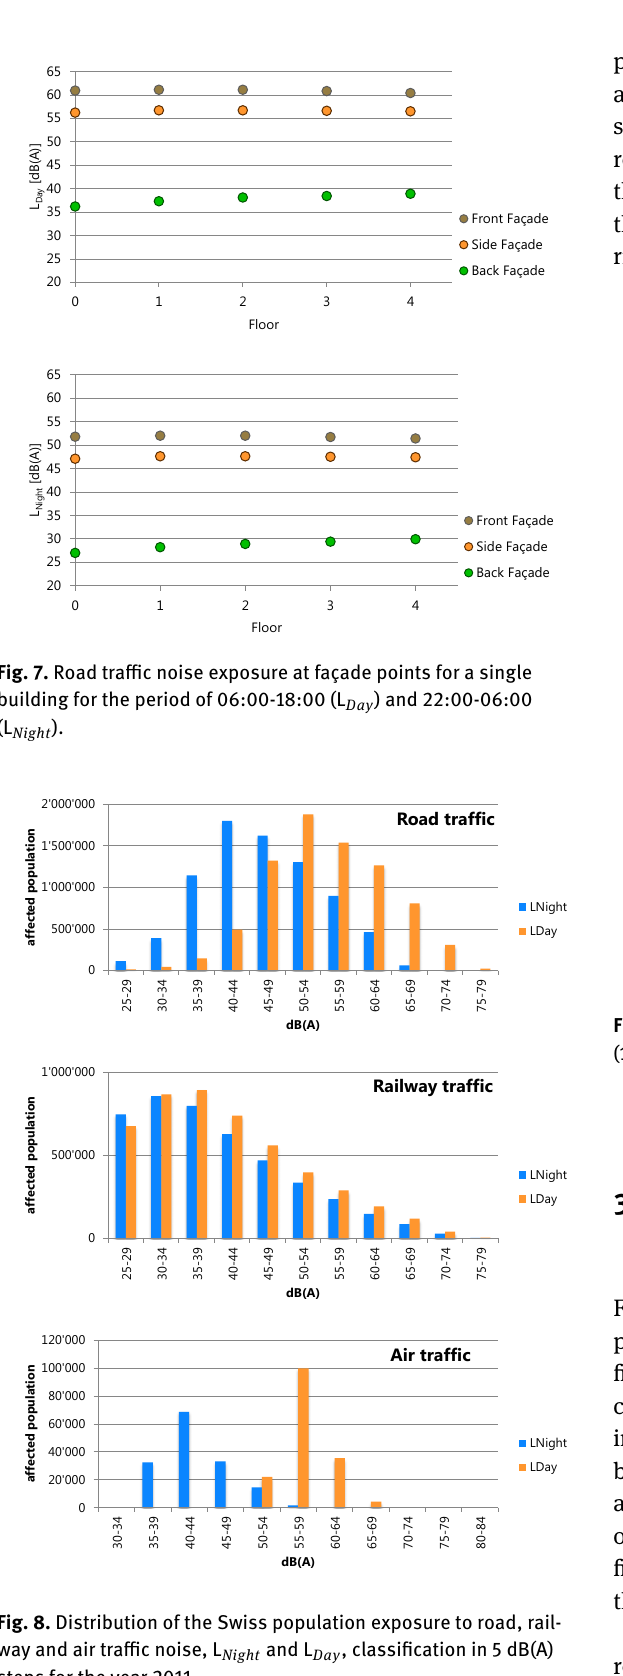
Fig. 8. Distribution of the Swiss population exposure to road, rail- way and air traffic noise, L Night and L Day , classification in 5 dB(A) steps for the year 2011.